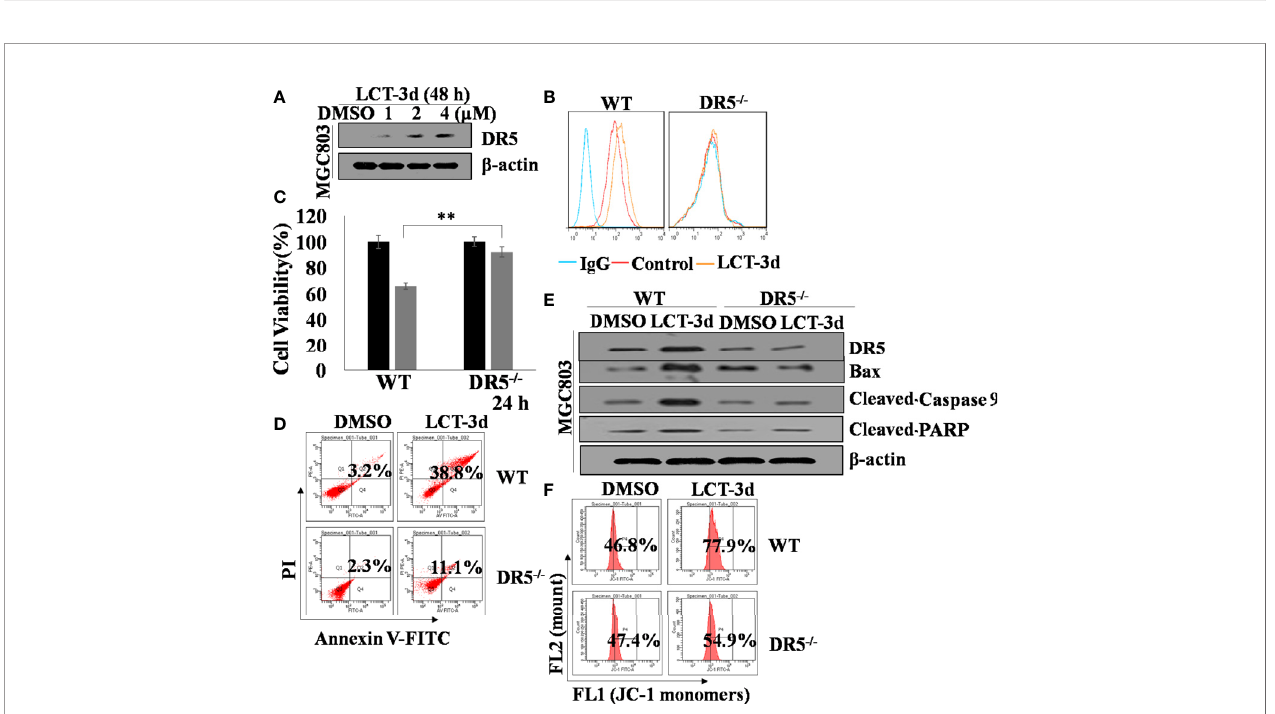
FIGURE 4 | LCT-3d-induced apoptosis is associated with extrinsic pathway in gastric cancer cells. Both wild type and DR5 − / − MGC803 cells were treated with 4 m M LCT-3d or indicated concentration. (A) Western blotting assay showed reduced expression of DR5 in a dose-dependent manner in MGC803 cells. (B) MGC803 cells and DR5 − / − MGC803 cells were treated with 4 m M LCT-3d for 24 h and DR5 protein expressions in MGC803 cells determined by fl ow cytometry. (C) MTT assay showed the cell viability after treatment with 4 m M LCT-3d for 24 h. **P < 0.01, signi fi cantly different compared with control. (D) Flow cytometric analysis showed the ratios of apoptotic cells after treatment with 4 m M LCT-3d for 24 h. (E) Western blotting assay showed the expression of the apoptosis-related proteins after treatment with 4 m M LCT-3d for 24 h. (F) Flow cytometric analysis demonstrated the reduction of MMP ( DY ) after treatment with 4 m M LCT-3d for 24